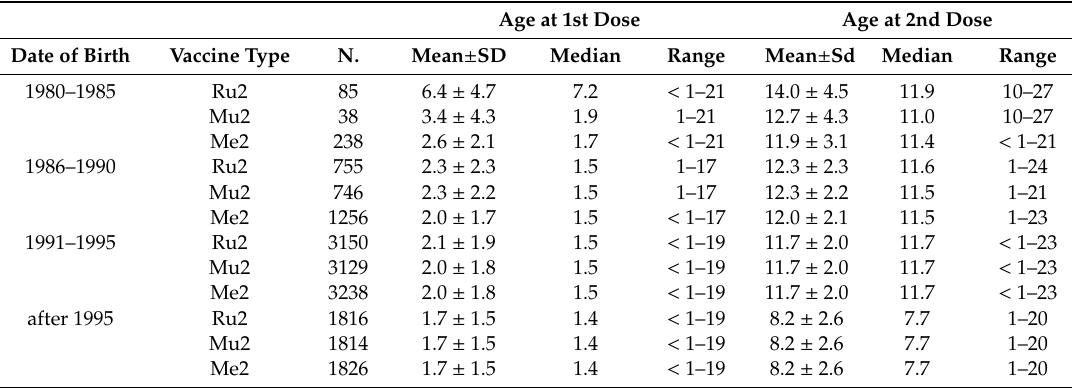
Table 5. Age of vaccination of students vaccinated